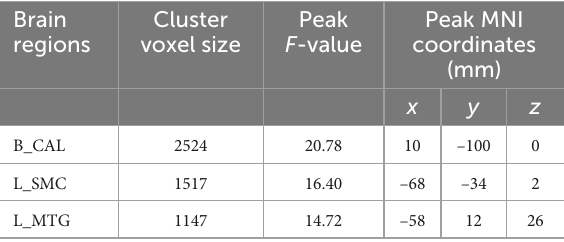
TABLE 2 Brain regions showing altered ReHo/CBF ratio among A-LHON, C-LHON, and HCs. Brain regions